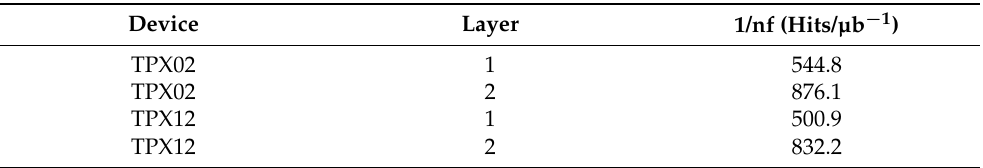
Table 14. Normalization (1/ n f ) to convert hit rates to luminosities. The larger values are for the thicker sensor layer. Taken from Ref.